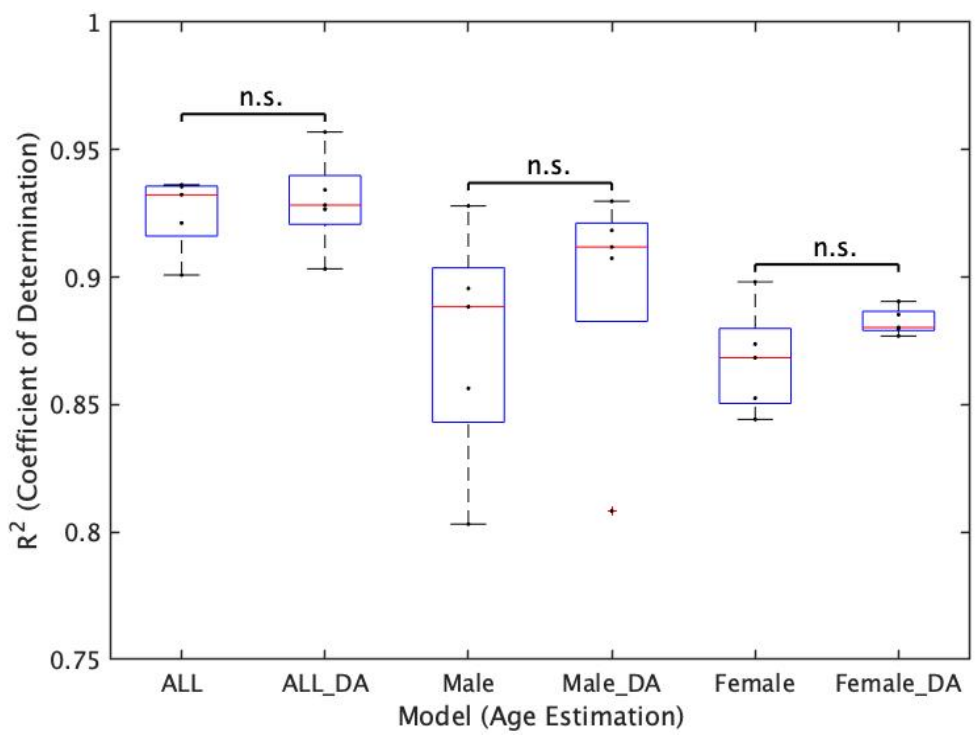
Figure 6. Results for the coefficient of determination (R 2 ). (DA: Data Augmentation).